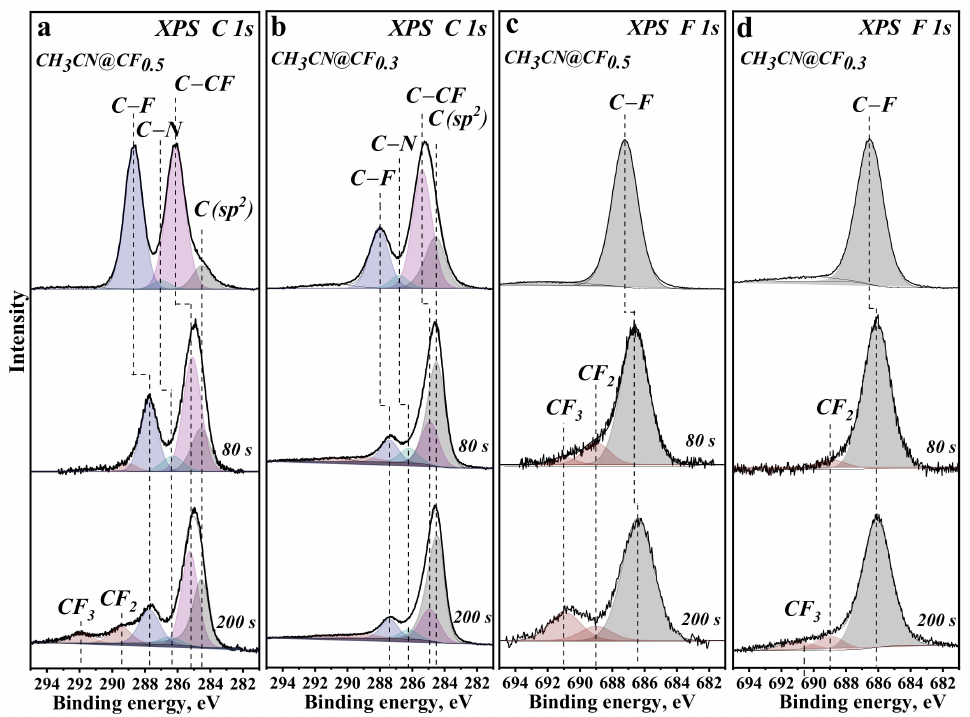
Figure 1. XPS C 1s spectra ( a , b ) and F 1s spectra ( c , d ) of CH 3 CN@CF 0.5 ( a , c ) and CH 3 CN@CF 0.3 ( b , d ) before and after white beam irradiation for 80 s and 200